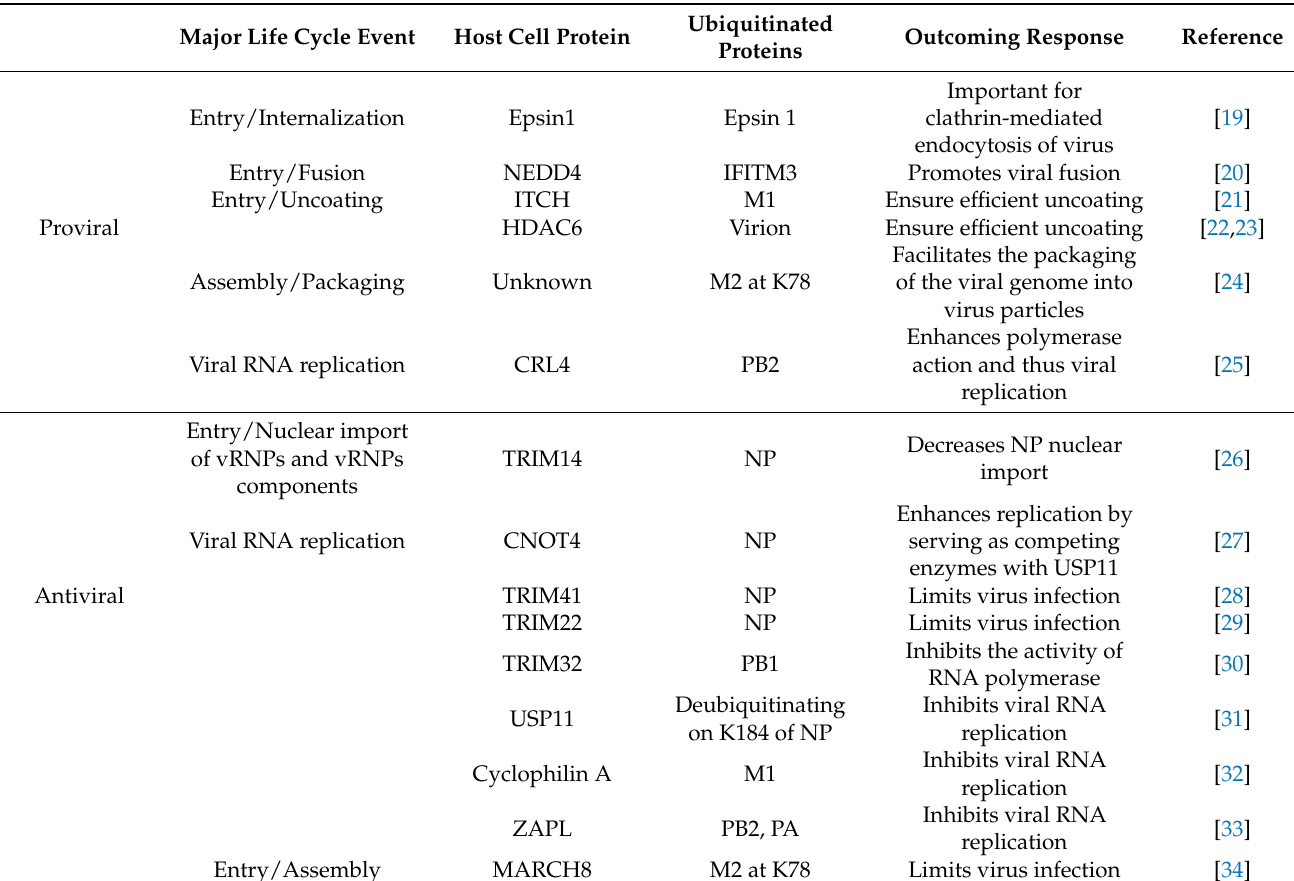
Table 1. Roles of ubiquitination in the influenza A virus